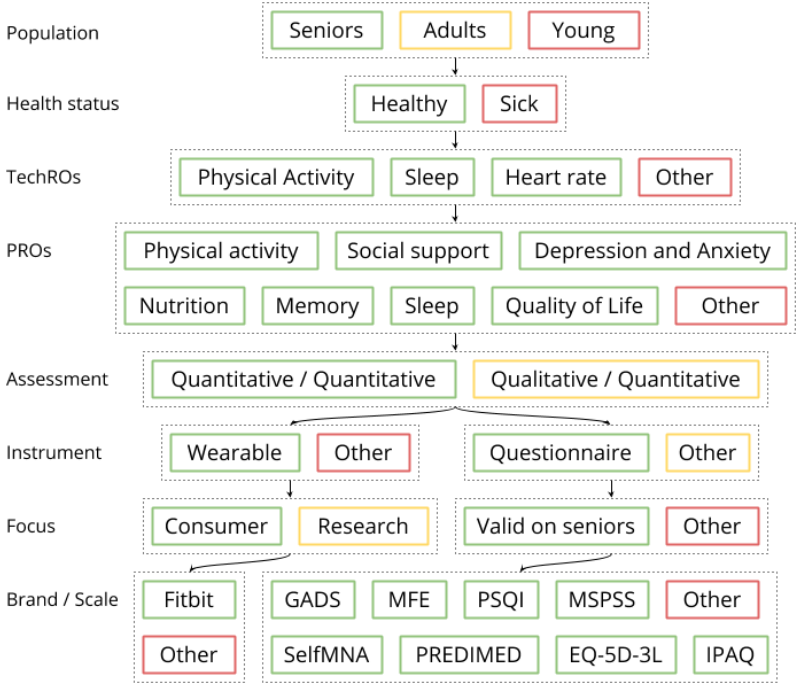
Figure A1. Related Work selection procedure (example on social support). Colors: green (positive towards inclusion), yellow (neutral), red (negative towards